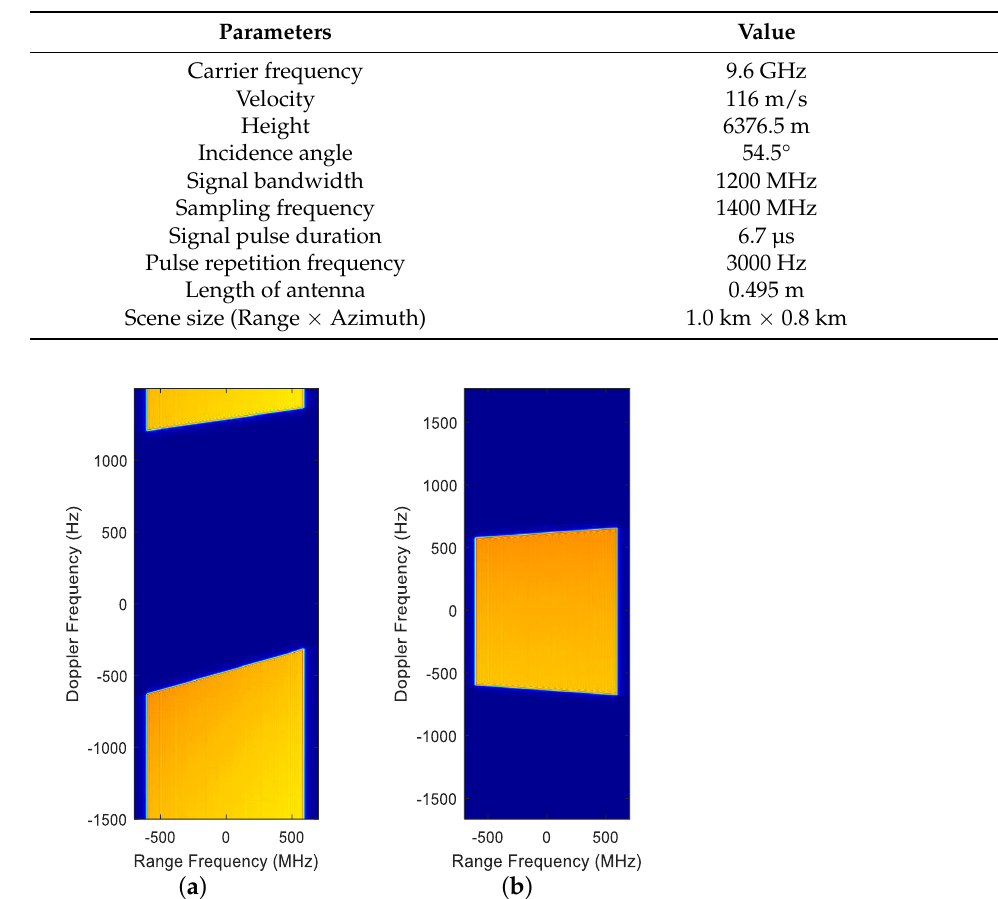
Table 1. Point Target’s Simulation Parameters.